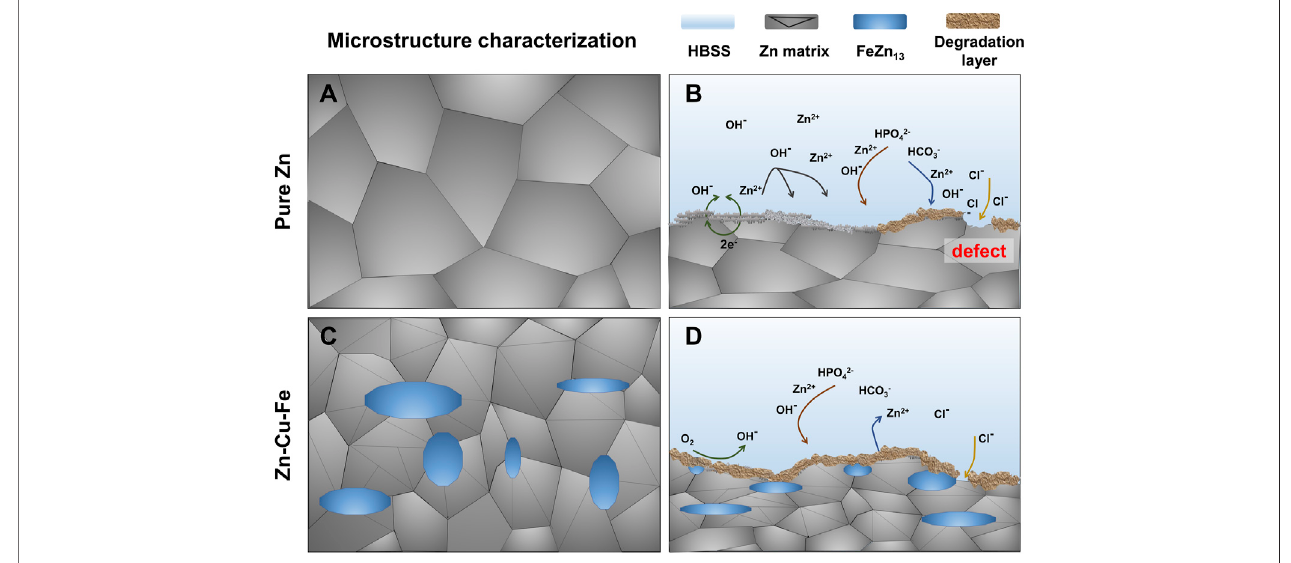
FIGURE 10 | Schematic illustration showing the degradation behavior of Zn and Zn-Cu-Fe alloy. Microstructure characterization of the pure Zn (A) and Zn-Cu-Fe alloy (B) ; the potential degradation mechanism of the pure Zn (C) and Zn-Cu-Fe alloy (D) .